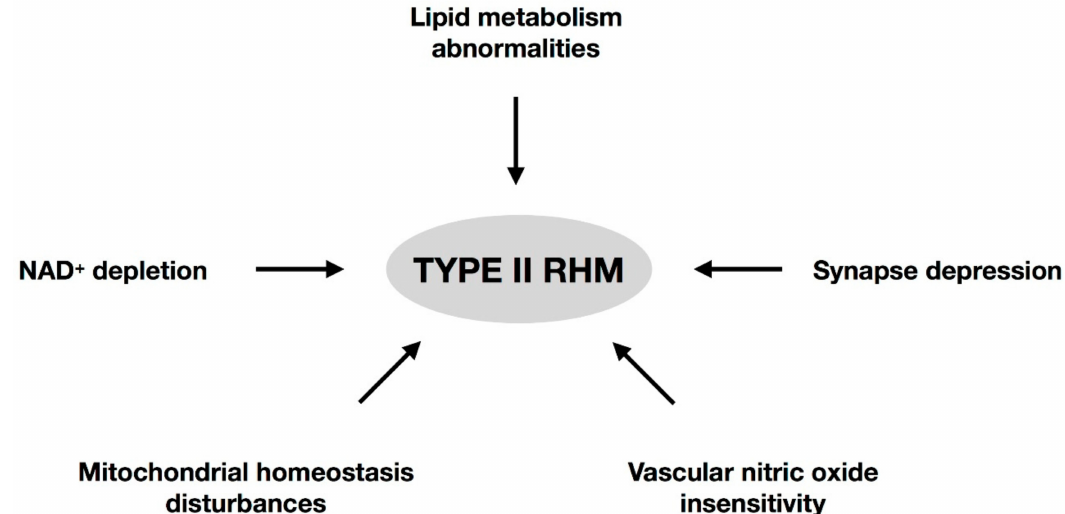
Figure 1. Scheme showing the pathways that could be involved in the etiopathology of the type II